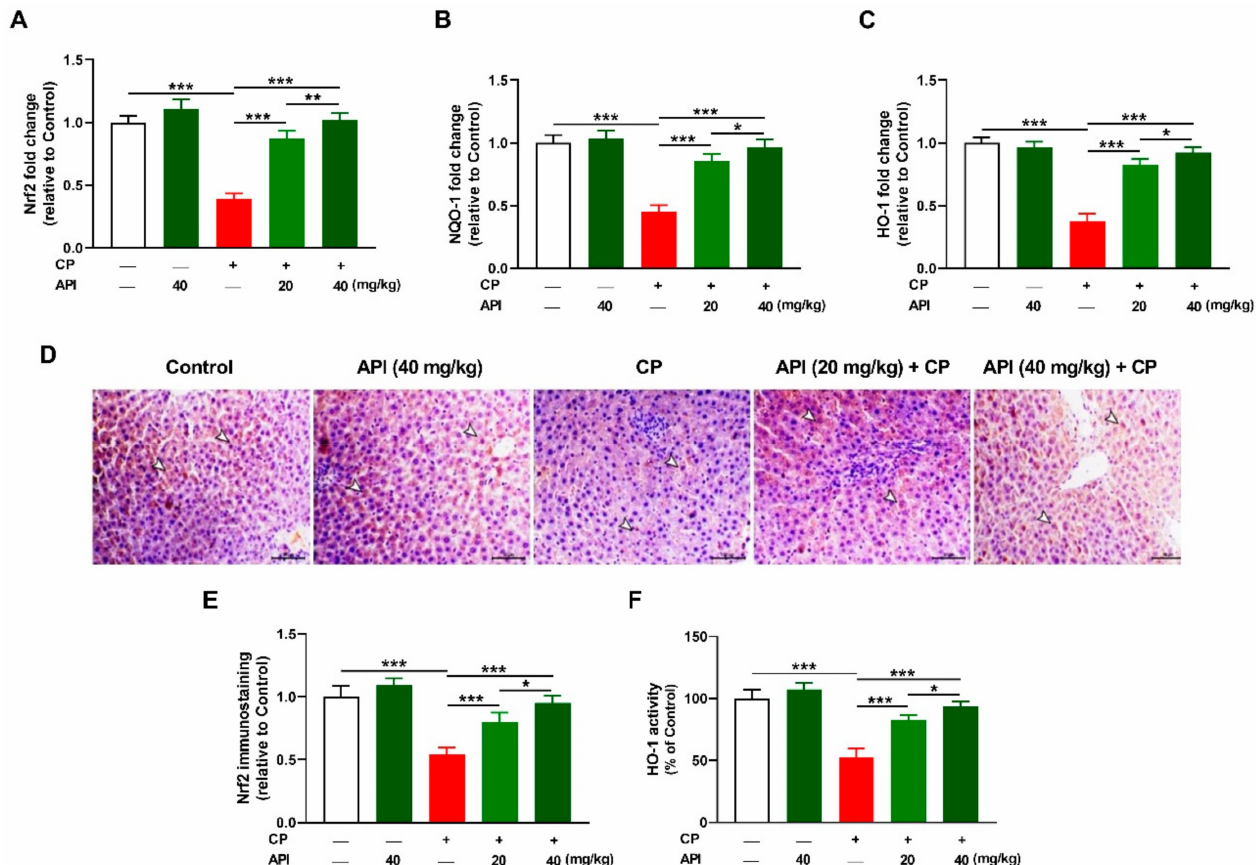
Figure 6. API activated hepatic Nrf2/HO-1 signaling in CP-intoxicated rats. API increased the ( A ) Nrf2, ( B ) NQO-1, and ( C ) HO-1 mRNA abundance, and ( F ) HO-1 activity in CP-administered rats. ( D ) Immunostaining of hepatic Nrf2 (arrowheads) showed a decrease in the expression in CP-administered rats and upregulation in the API-treated groups. ( E ) Image analysis of Nrf2 im- munostaining. Data are mean ± SEM, ( n = 6). * p < 0.05, ** p < 0.01, and *** p <